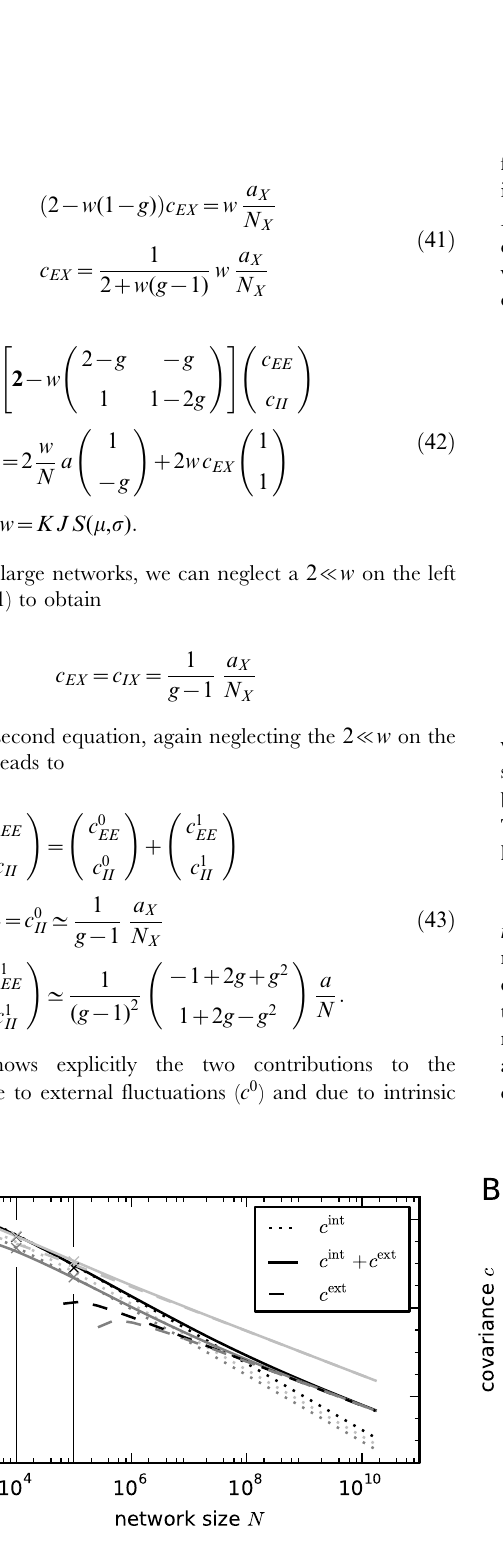
Figure 7. Scaling the network size to infinity. Comparison of the solution of (24) (solid) to the contribution of the leading order in 1 = N (dashed). Gray coded are the different pairs of covariances, black ( c EE ), mid gray ( c II ), light gray ( c EI ). A Network as in [24] with non-homogeneous synaptic coupling as in Figure 4. The dashed curve is given by the leading order term c ext : fluctuations, the dotted curve is the next order term r intr : ! N { 3 2 (37), driven by intrinsic fluctuations generated by the excitatory and inhibitory population. The dashed curve is not shown for networks smaller than * 10 6 neurons as it assumes negative values. Relative error of the theory with respect to simulation at 100,000 neurons is 73 percent. The solid curve is the full solution of (24) c ab ~ r ext : neurons is 16 percent. Symbols show direct simulations. B Network with homogeneous connectivity, as in Figure 6. Same symbol code as in A. Both ! N { 1 (36) and r intr : ! N { 1 (37) show the same scaling (44). Note that for the parameters here c ext : contributions c ext : ab . Symbols indicate the results of direct simulations; vertical lines are included to guide the eye. shown is c ext : EI